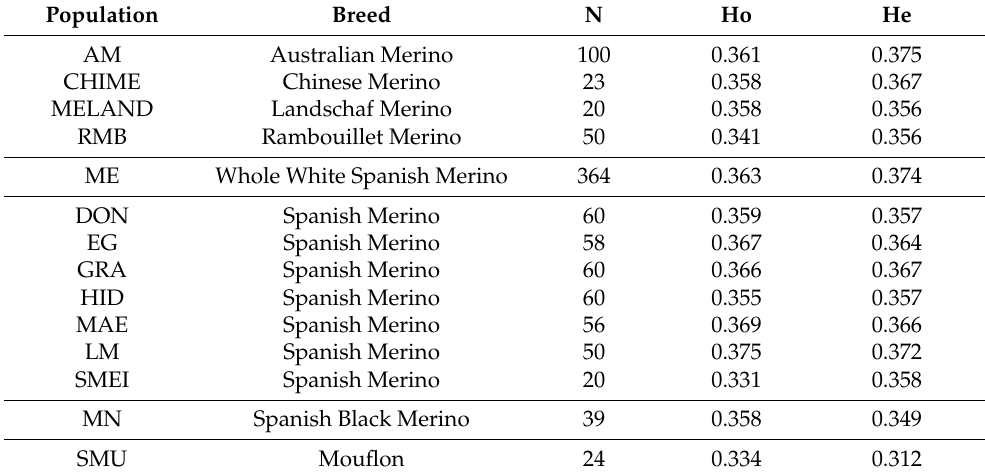
Table 1. Observed (Ho) and expected heterozygosity (He) of the analyzed population (breed, ge- netic lines, and species). Breeds: AM (Australian Merino), CHIME (Chinese Merino), MELAND (Landschaft Merino), RMB (Merino of Rambouillet), MN (Spanish Black Merino), and ME (Spanish White Merino). Genetic lines within the ME breed: DON (Donoso), EG (Egea), GRA (Granda), HID (Hidalgo), MAE (Maesso), LM (L ó pez-Montenegro). Undifferentiated Spanish Merino SMEI (Spanish Merino from Industrial Breeding). Outgroup species: SMU (Mouflon). N, number of individuals. Ho, observed heterozygosity. He, expected Heterozygosity. Population